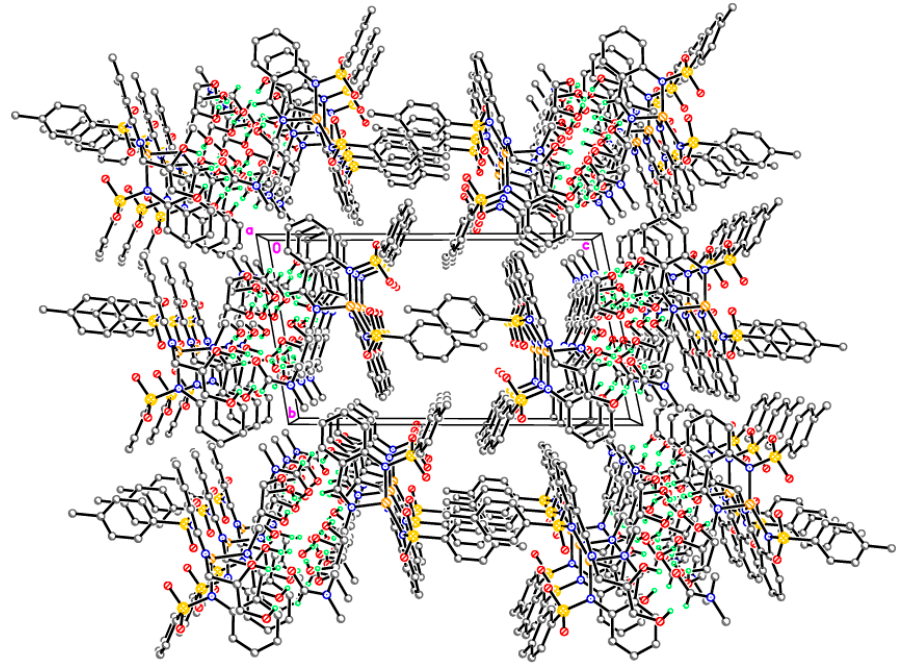
Figure 5. Crystal packing of 2-Zn demonstrating the H-bonded chains of the H-bonded dimers along